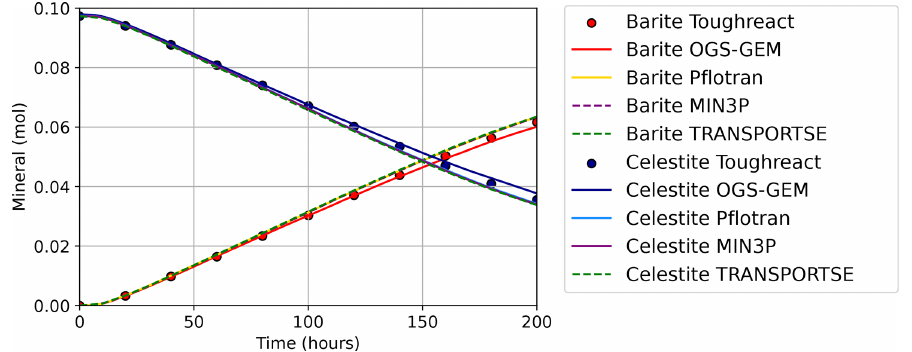
Figure 11. Temporal development of the mineral composition in the flow cell calculated by TRANSPORTSE-PHREEQC in comparison against the results documented by Poonoosamy et al.